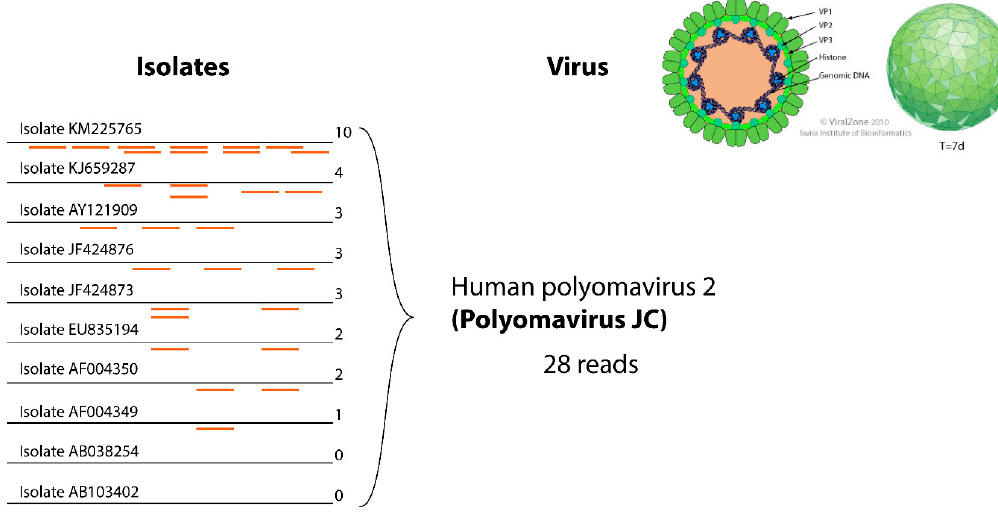
Figure 3. Example of gathering reads for the same virus. In the left part, 10 isolates represent clusters for this virus. Twenty-eight reads show homology to those reference sequences, they can be all grouped under the “human polyomavirus 2” entity, thereby facilitating interpretation of results.